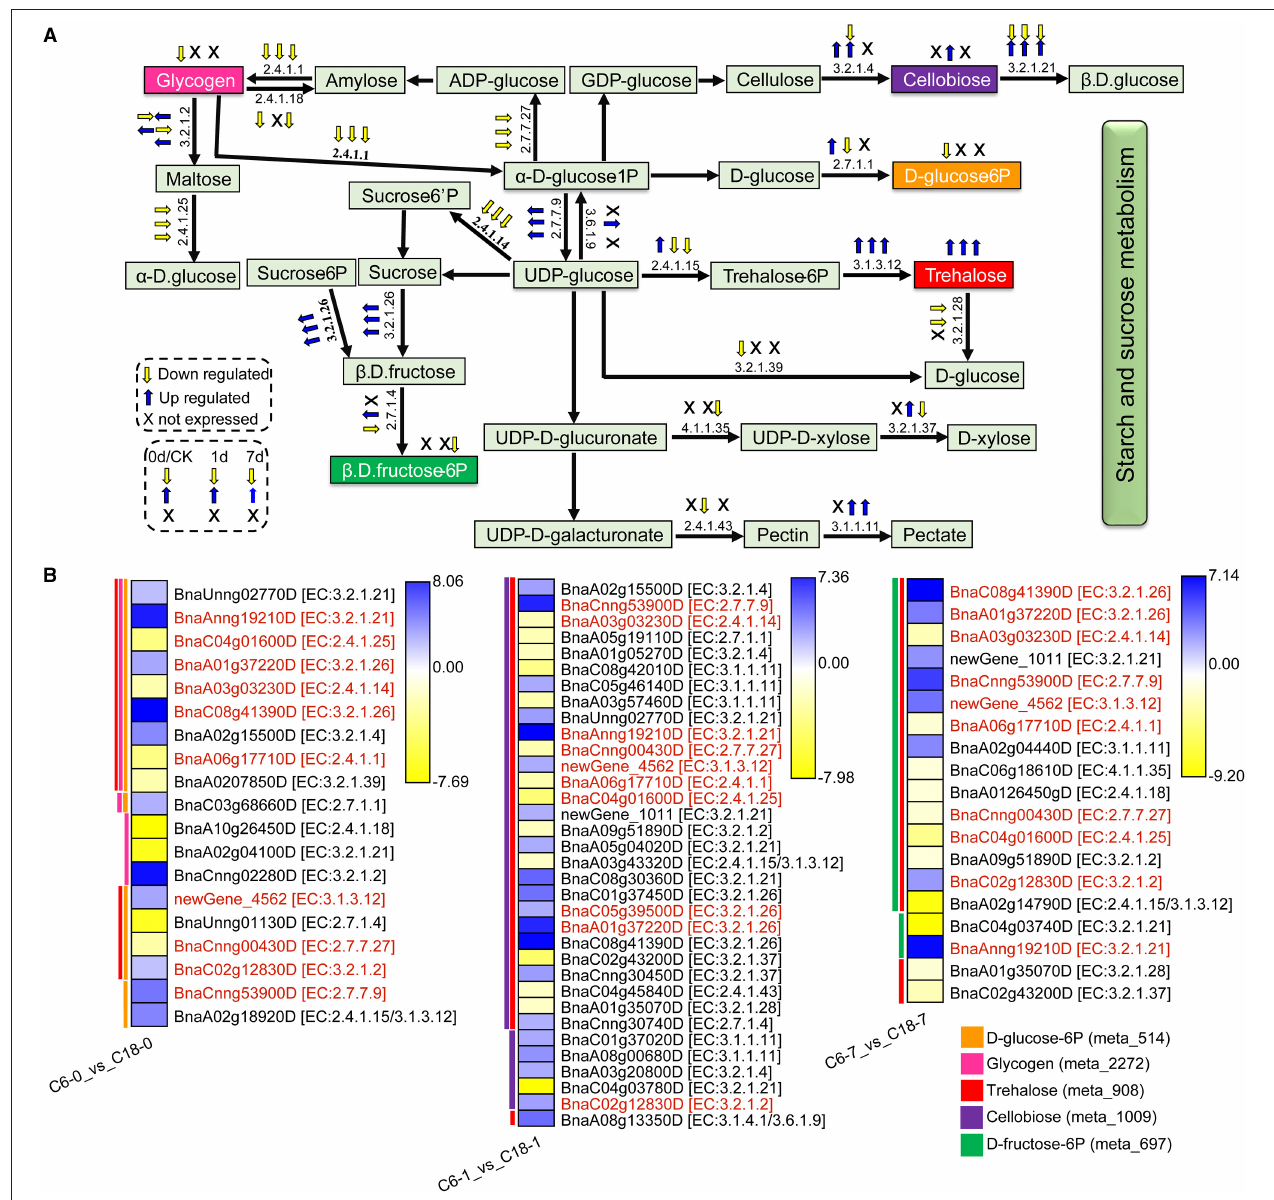
FIGURE 9 | The proposed layout of the starch and sucrose metabolism pathway in response to CS in C6 and C18 cultivars. (A) Layout showing the DEGs involved in starch and sucrose metabolism. Colored boxes indicate the metabolites observed in this pathway. This pathway shows only the DEGs that have been correlated with the metabolites from the combined analysis of transcriptomes and metabolomes. The yellow and blue arrows indicate the expression pattern (up-/downregulated) of DEGs based on the three comparisons, i.e., C6-0 vs. C18-0, C6-1 vs. C18-1, and C6-7 vs. C18-7, whereas “X” indicates not expressed at specific time points. (B) Heatmap showing the expression of DEGs corresponding to “A.” Red text color for gene names indicating the shared/common DEGs. Colored bars on the left side of each heatmap showing the metabolites correlated with DEGs based on Pearson correlation coefficient (PCC) analysis. The enzyme commission (EC) numbers are as follows: 2.4.1.1, glycogen phosphorylase; 2.4.1.14, sucrose-phosphate synthase; 2.4.1.15/3.1.3.12, trehalose 6-phosphate synthase/phosphatase; 2.4.1.18, 1,4-alpha-glucan branching enzyme 2-2; 2.4.1.25, 4-alpha-glucanotransferase; 2.4.1.43, alpha-1,4-galacturonosyltransferase; 2.7.1.1, hexokinase; 2.7.1.4, fructokinase; 2.7.7.9, UTP–glucose-1-phosphate uridylyltransferase; 2.7.7.27, glucose-1-phosphate adenylyltransferase; 3.1.1.11, pectinesterase; 3.1.3.12, trehalose 6-phosphate phosphatase; 3.2.1.2, beta-amylase; 3.2.1.4, endoglucanase; 3.2.1.21, beta-glucosidase; 3.2.1.26, beta-fructofuranosidase; 3.2.1.28, alpha, alpha-trehalase; 3.2.1.37, beta-D-xylosidase 4; 3.2.1.39, glucan endo-1,3-beta-glucosidase 5/6; 3.1.4.1/3.6.1.9, ectonucleotide pyrophosphatase/ phosphodiesterase family member 1/3; 4.1.1.35, UDP-glucuronate